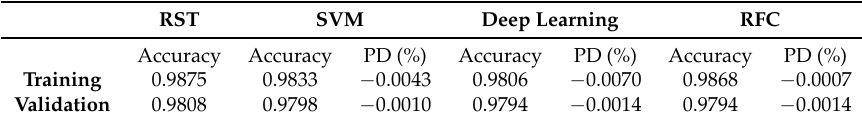
Table 7. Training and testing accuracies for RST and other methods and their percent difference with